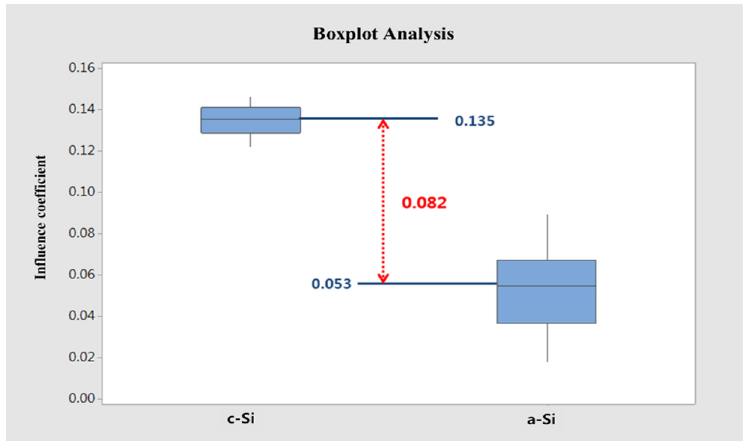
Figure 11. Box plot analysis of the influence coefficients (installation direction: west; installation angle: 3°).